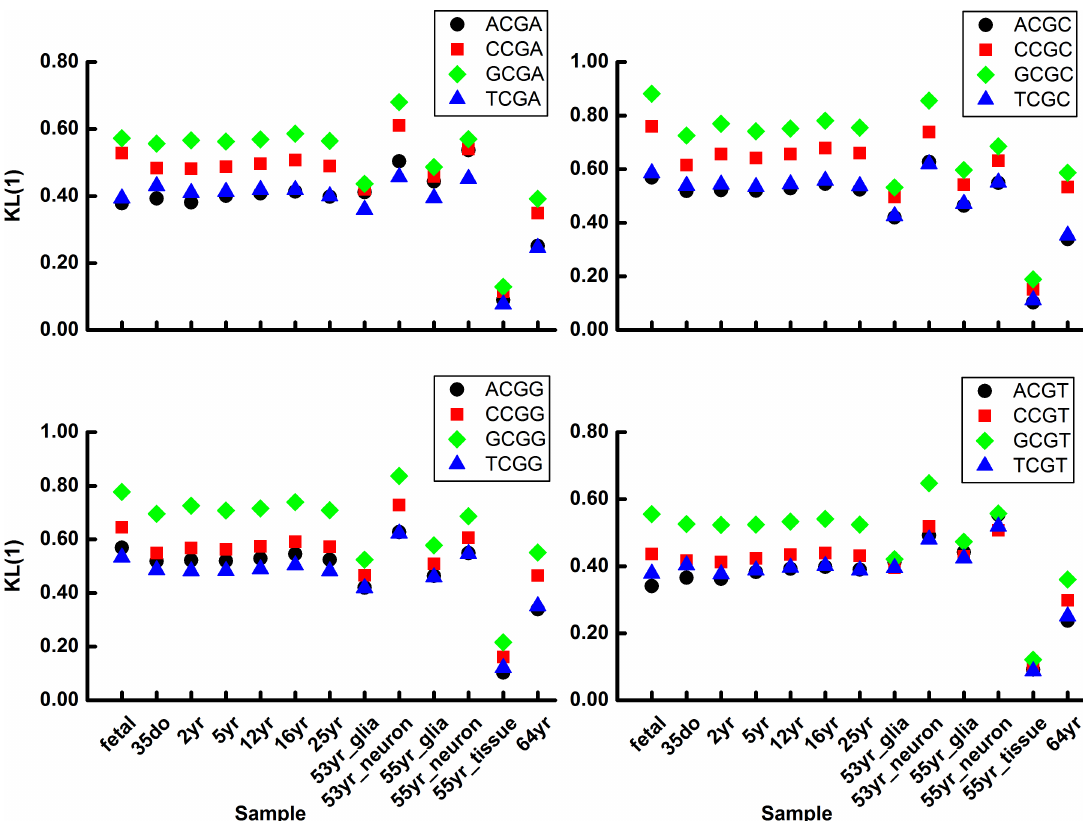
Fig 3. Demethylation variation of N 5 CGA (upper left), N 5 CGC (upper right), N 5 CGG (lower left) and (D) N 5 CGT (lower right) in human brain cells.